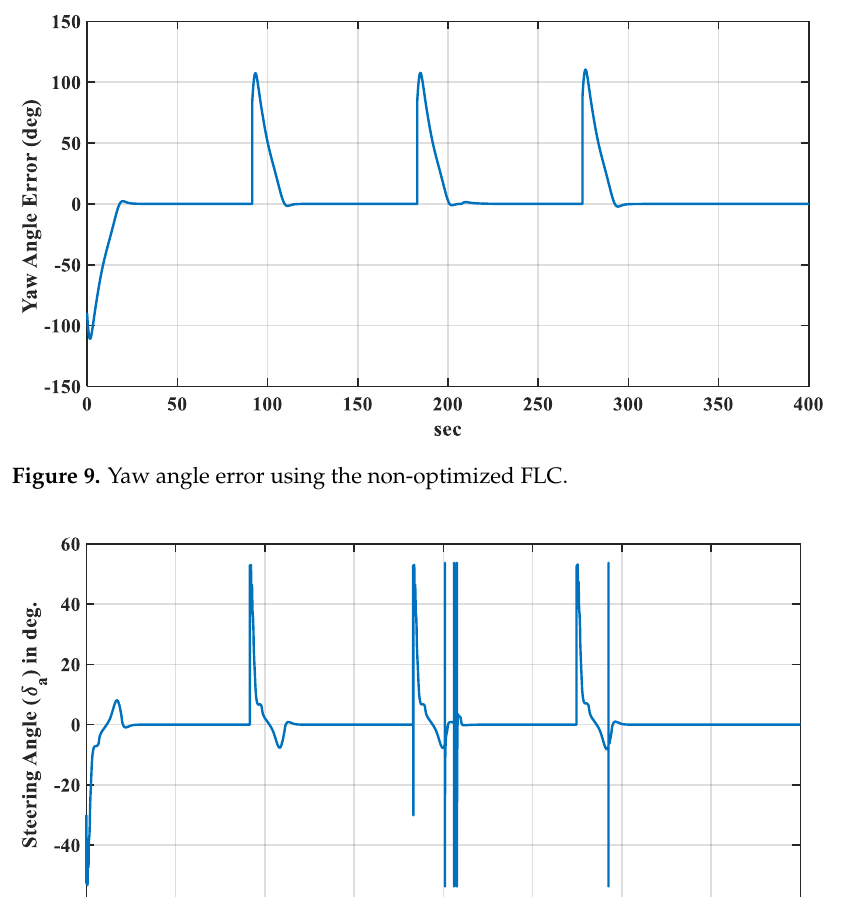
Figure 8. PPC lateral path using the non-optimized FLC.